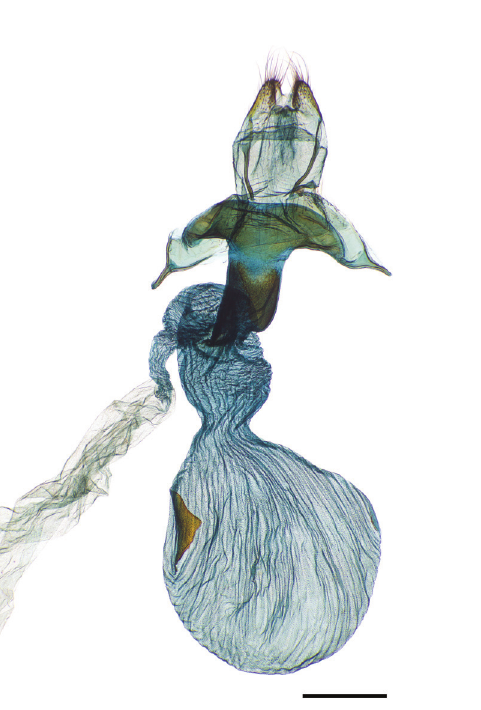
Figure 24. Female genitalia, A. nefascia USNM dissection #148066. Note presence of two signa, one